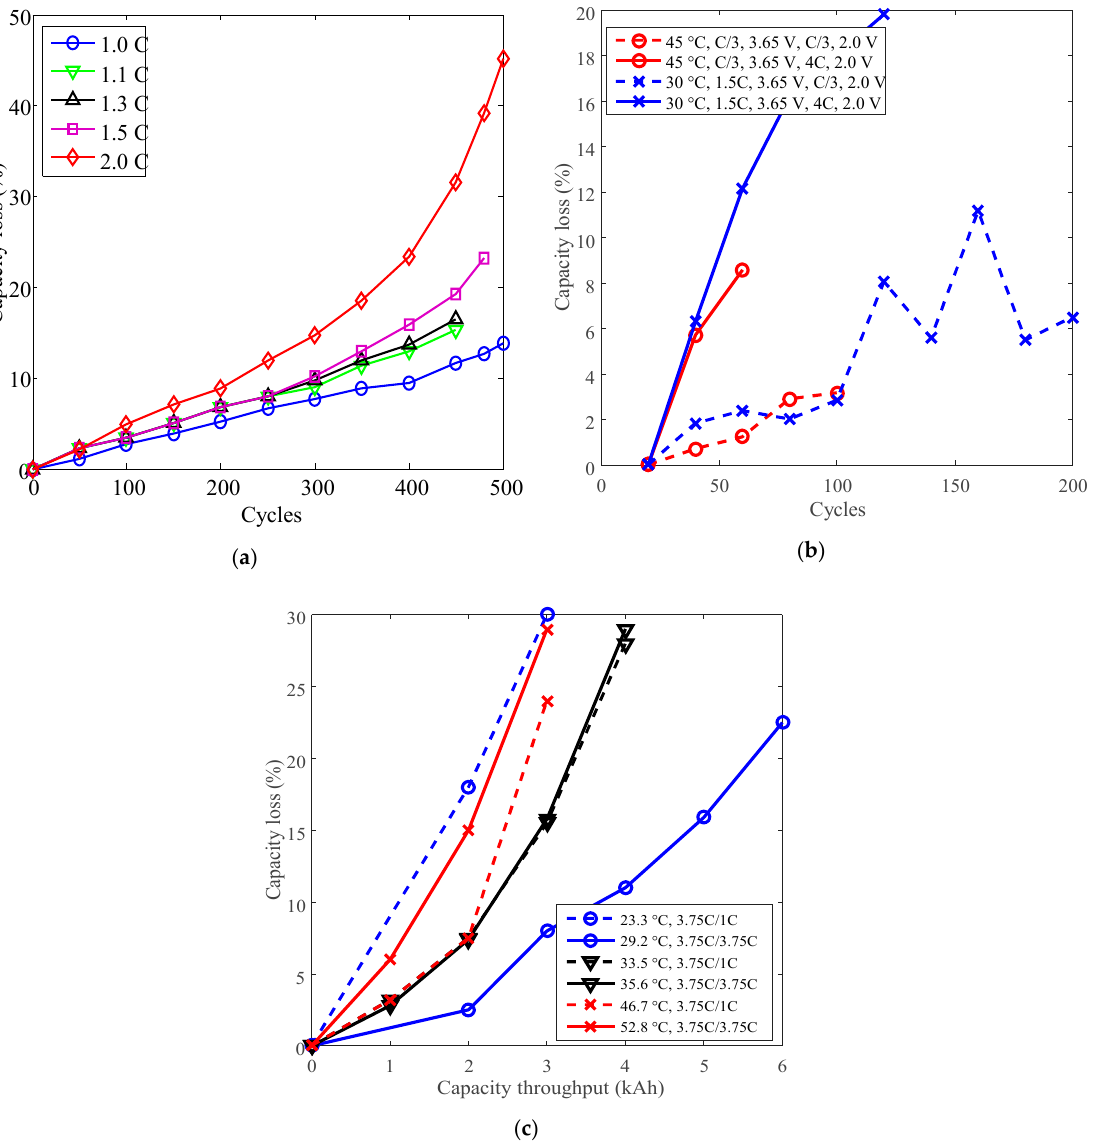
Figure 7. Battery cycle degradation data under various discharge C-rates. (a) Battery O charged CC 1C to 4.2 V, constant voltage (CV) to 90 mA, discharged CC to 2.75 V under 25 °C. (b) Battery G. (c) Battery P.